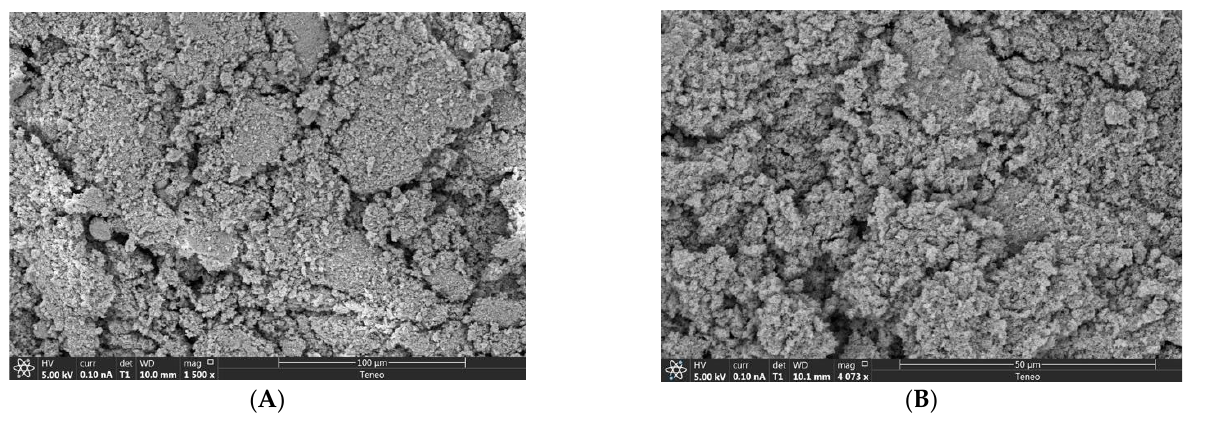
Figure 4. SEM images of Bipy-PAN, scale bar = 100 µ ( A ), 50 µ ( B ).